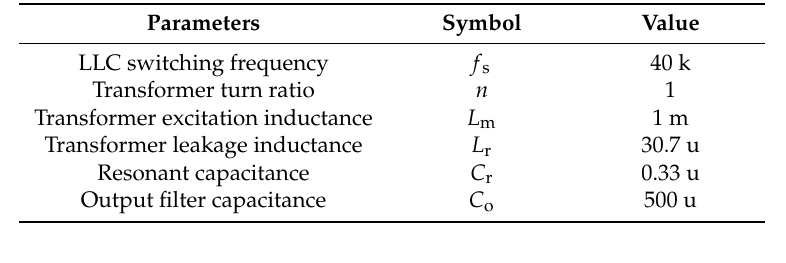
Table 2. Parameters of LLC resonant Converter.